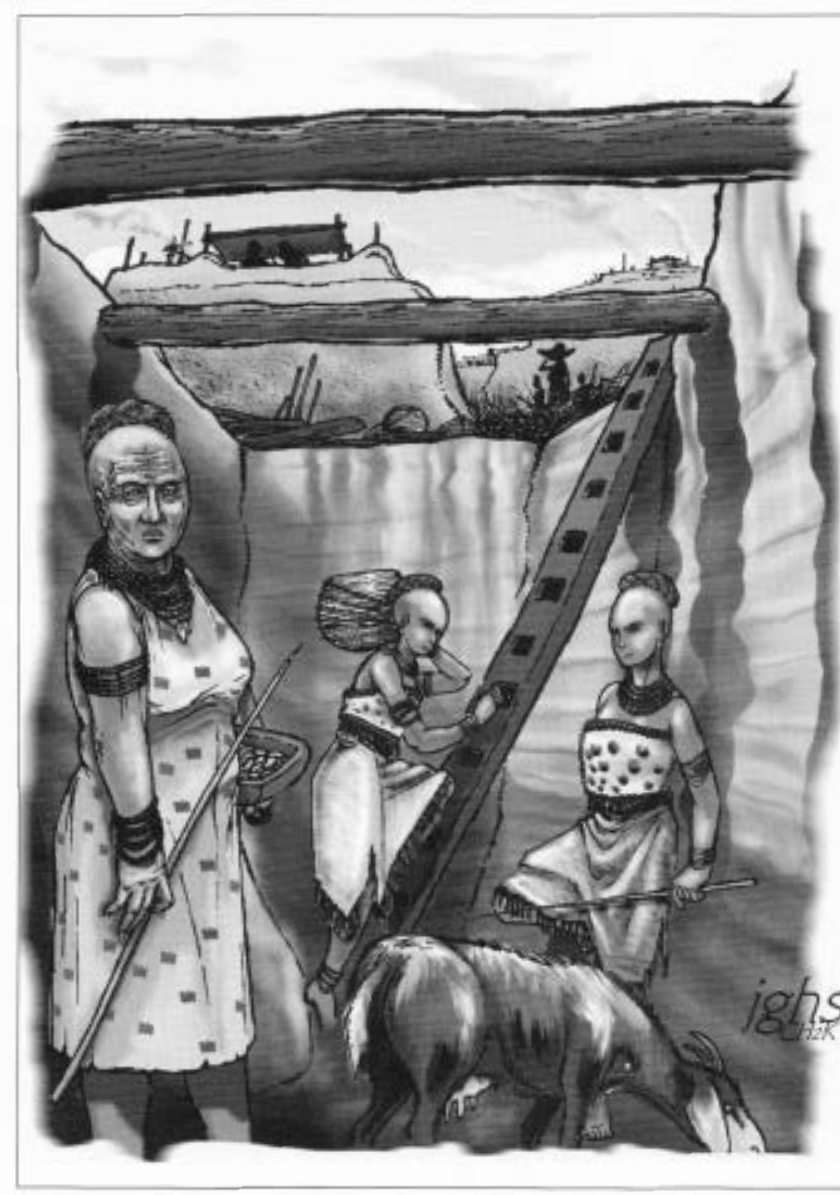
Figure 6 An artist's computer-aided reconstruction, by fah n-Gordon Swagger, of the area thought to have been used for penning young sheep or goats (or both) at (:atalhoyiik; the dress of the women is based on figurines and wall paintings found at the site. animals represented suggests that they made easier prey than younger ones.